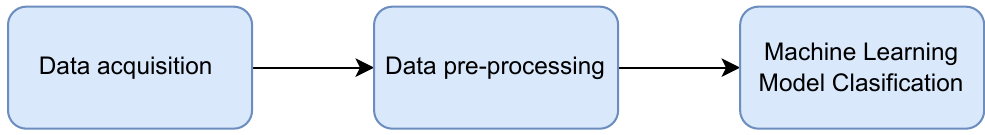
Figure 1. Simplification of the ML